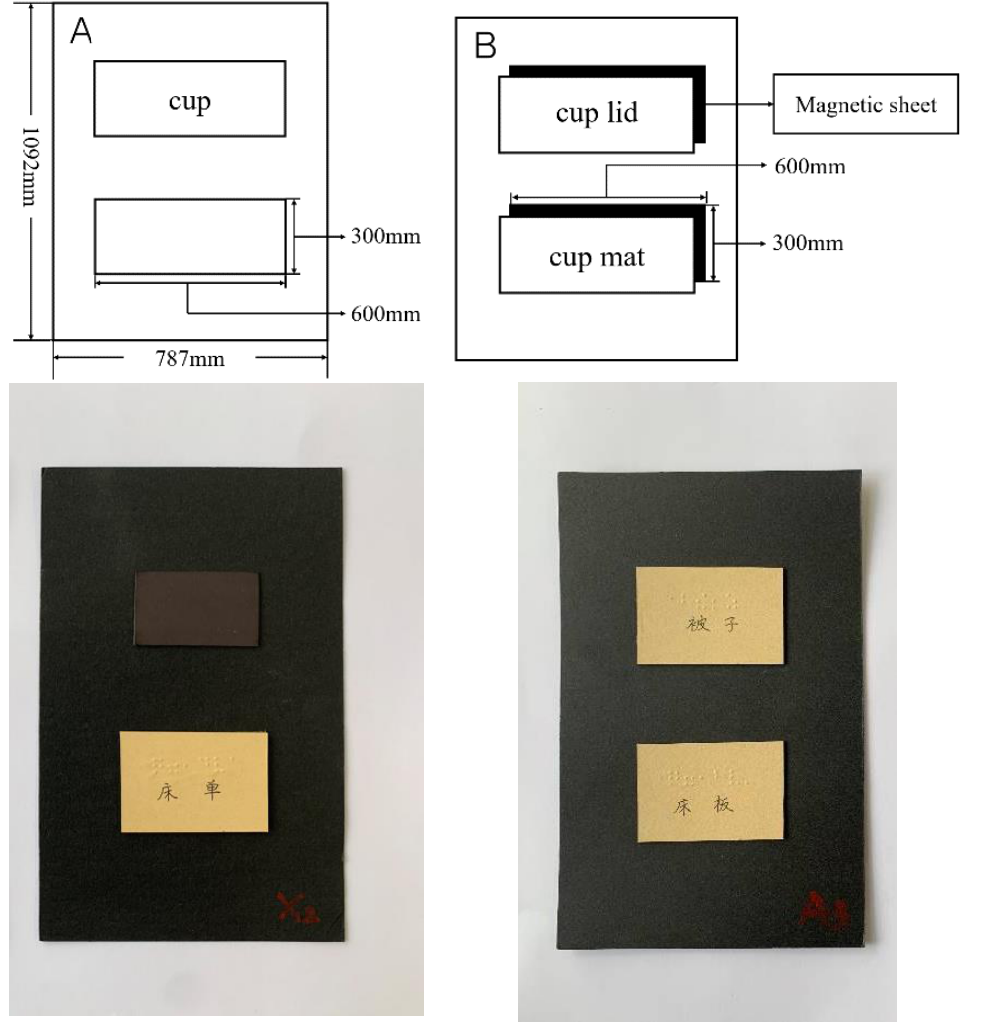
Figure 3. Schematic diagram of word cards in Experiment 2. ( A ) A test word card; ( B ) an alternative word card. In this example, the alternative words present “cup lid” and “cup mat” while the test word “cup” is presented on the upper of A. The correct answer is to select “cup mat” from B and place it in the blank space below the “cup” of A. Below the illustrations are the materials used in the experiment. In the two images: “ 床单 ” means “bed sheet” in Chinese, “ 被子 ” means “quilt”, “ 床板 ” means “bed board”.